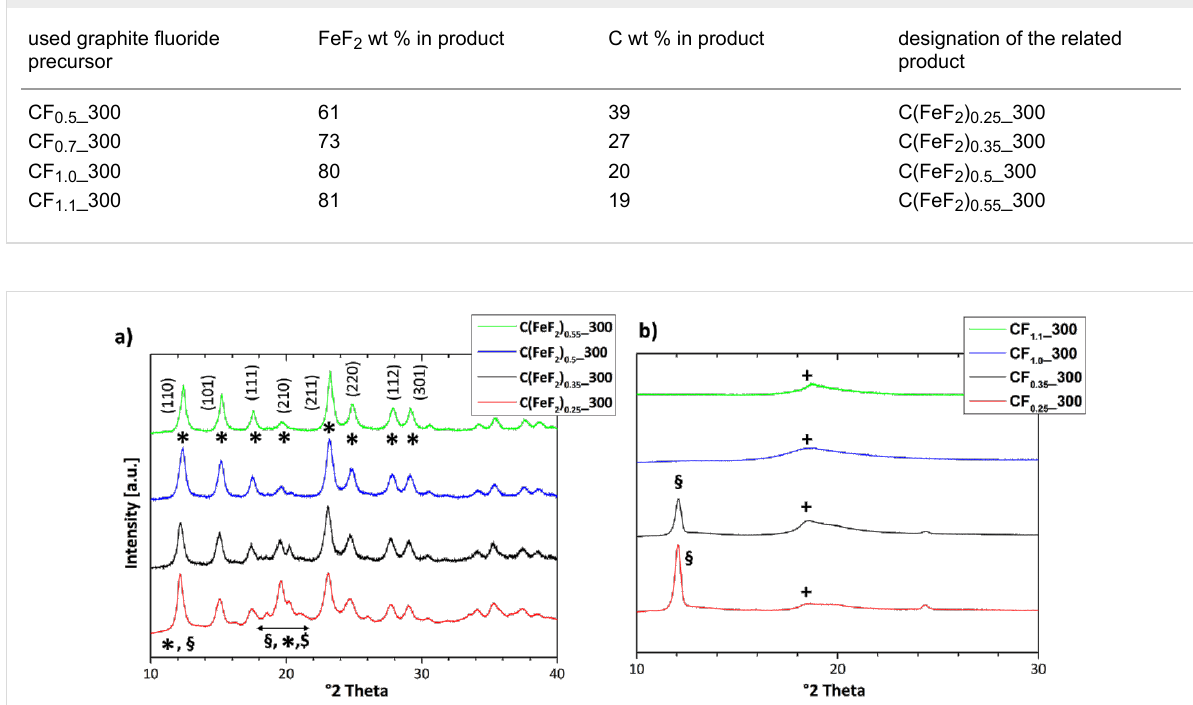
Table 1: Graphite fluoride precursors and composition of the respective products.